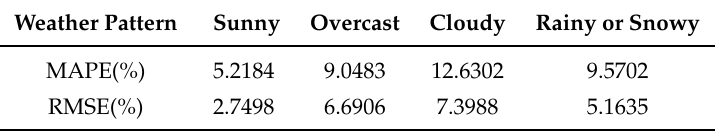
Table 2. Forecasting performance under four generalized weather